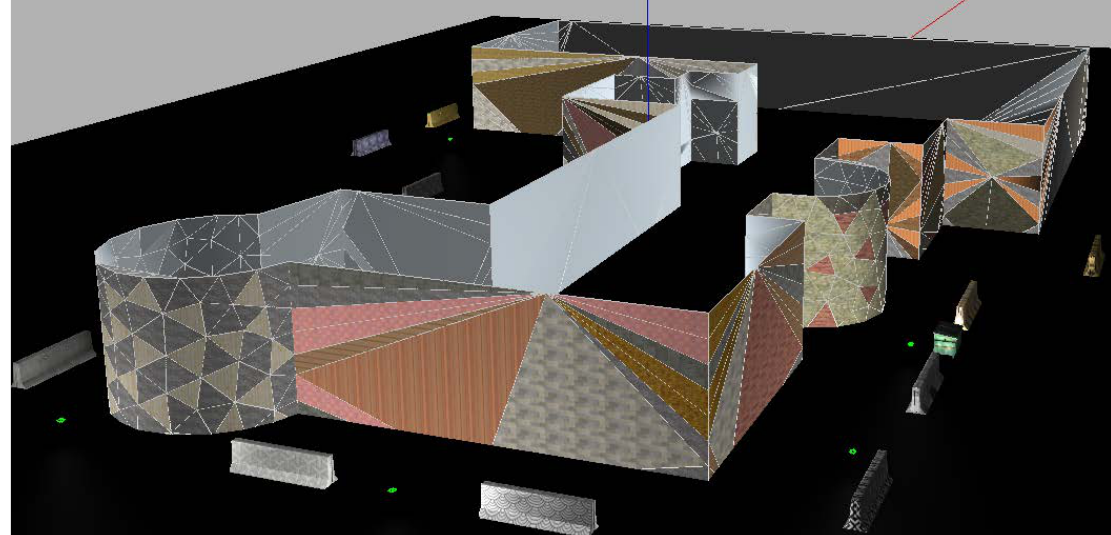
Figure 15. The complex building used to evaluate the performance of the algorithm.